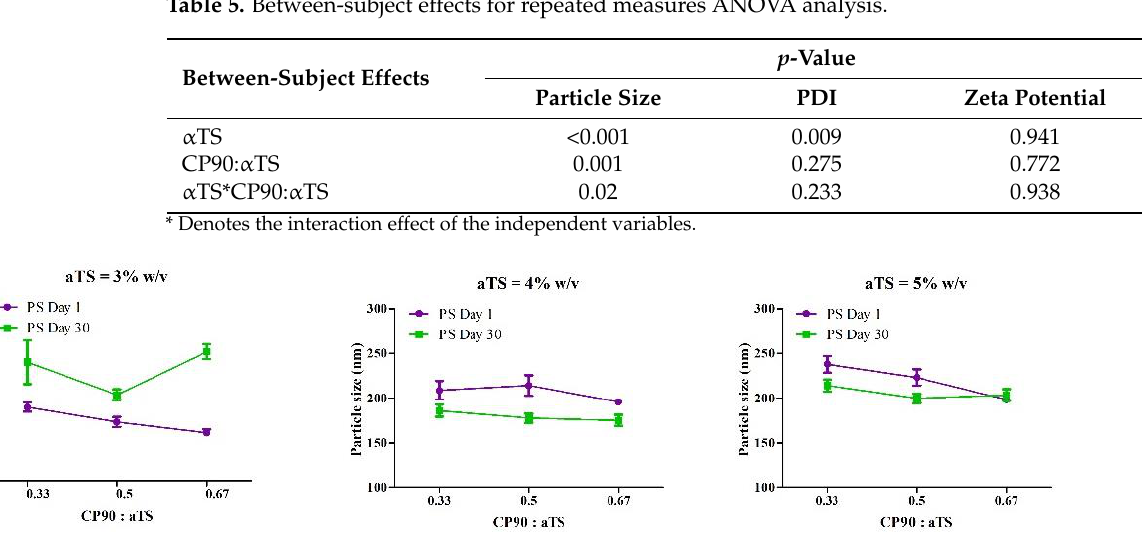
Table 5. Between-subject effects for repeated measures ANOVA analysis.